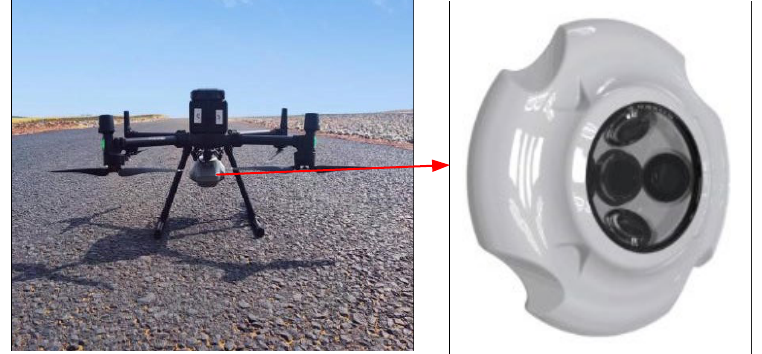
Figure 5. UAV for sand accumulation air survey and camera lens.